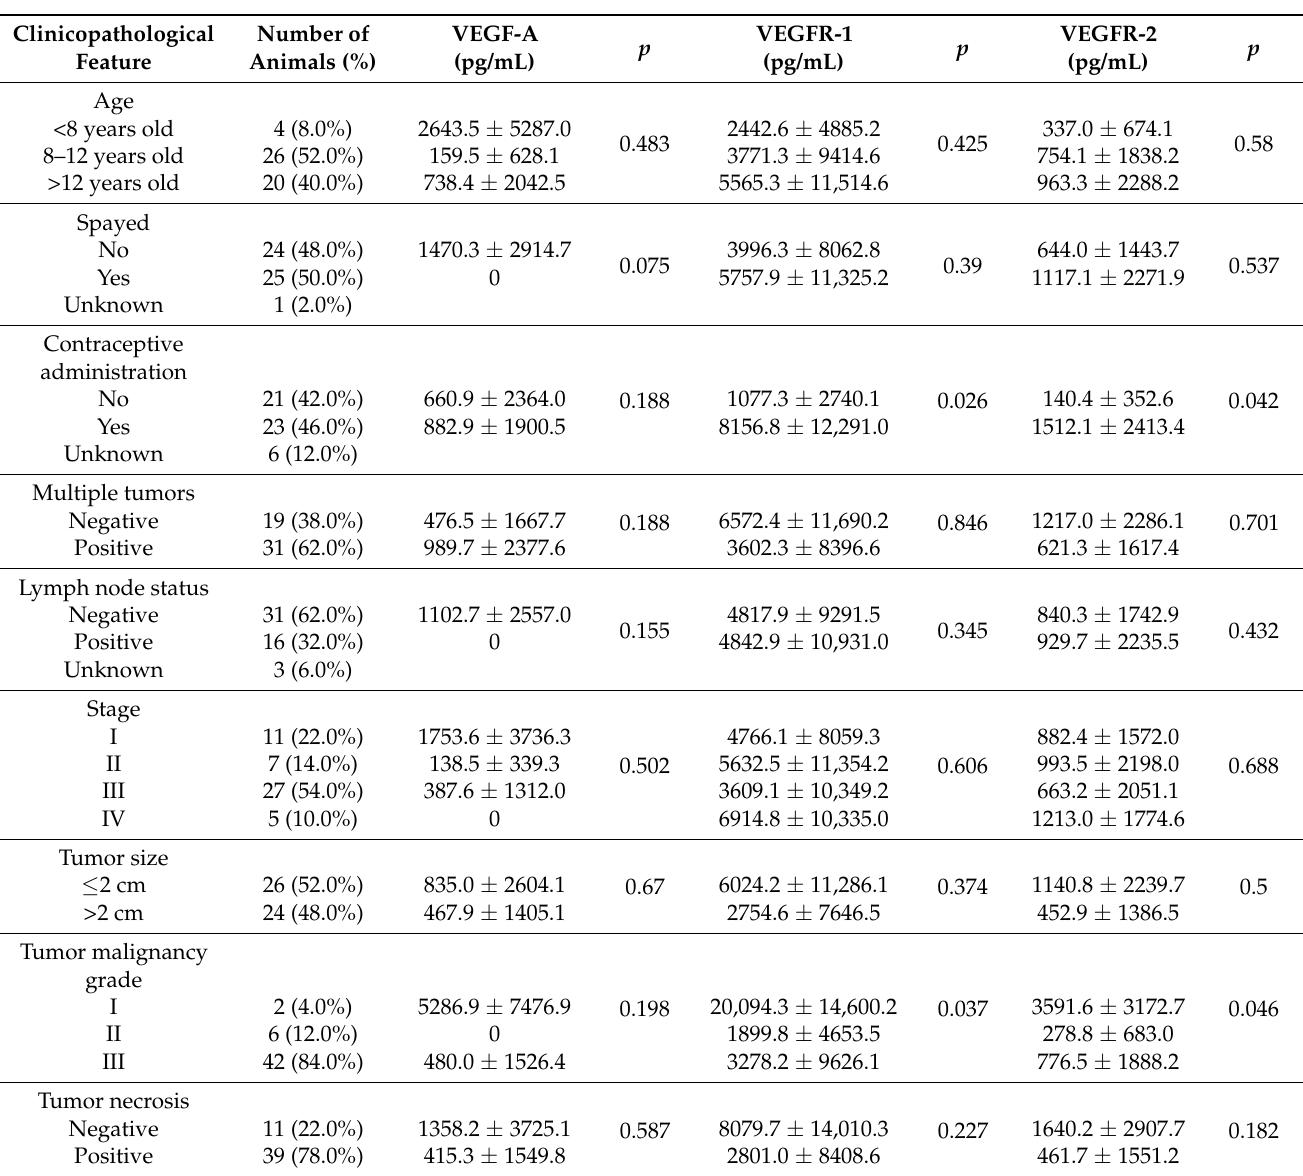
Table 1. Statistical associations between serum VEGF-A, VEGFR-1 and VEGFR-2 levels and clinicopathological parameters examined in cats with mammary carcinoma (mean values ± standard